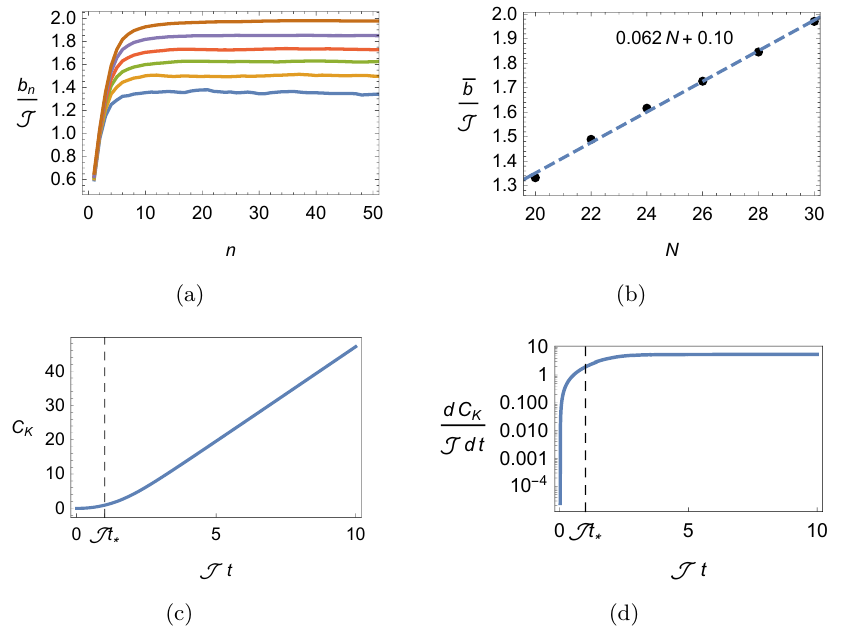
Figure 2 . (a) The Lanczos coefficient of the SYK model. The curves from the bottom to the top correspond to q = 4 and N = 20 , 22 , 24 , 26 , 28 , 30 , respectively. (b) The plateau value of the Lanczos coefficient at different N . ¯ b given by the plateau value of the Lanczos coefficient n > N/q . The dashed line is fitted by a linear function, showing that the platue value is proportional to N . (c) √ The K-complexity of the Heisenberg operator 2 ψ 1 ( t ) in the SYK model. We use the parameters q = 4 and N = 30 . (d) The time derivative of the K-complexity shown in (c). The scrambling time is denoted by t ∗ . Due to the small system size, the exponential growth is not